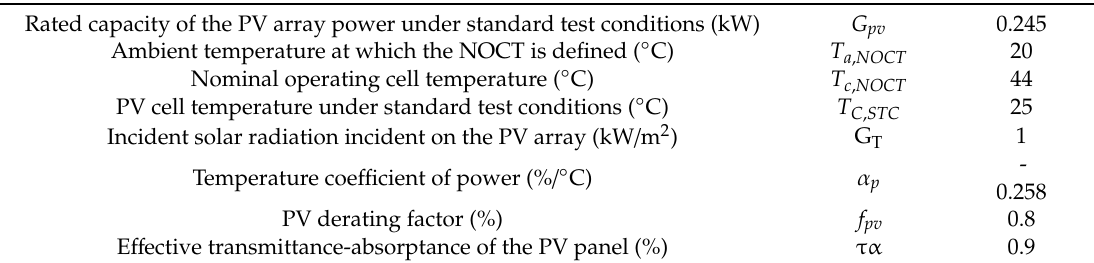
Table 2. Main input data used in the solar panel simulation [32].